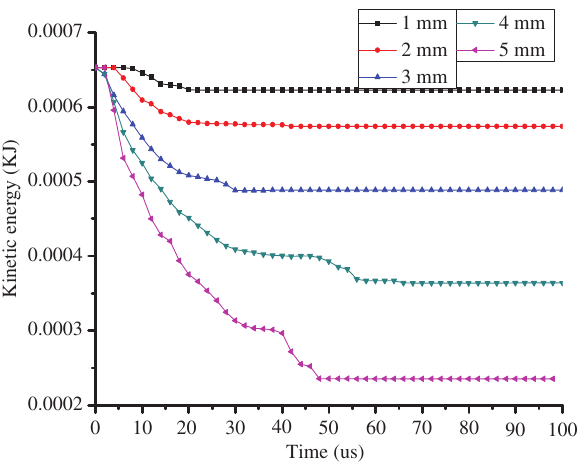
Figure 5: Target plate thickness-specific energy absorption curve.